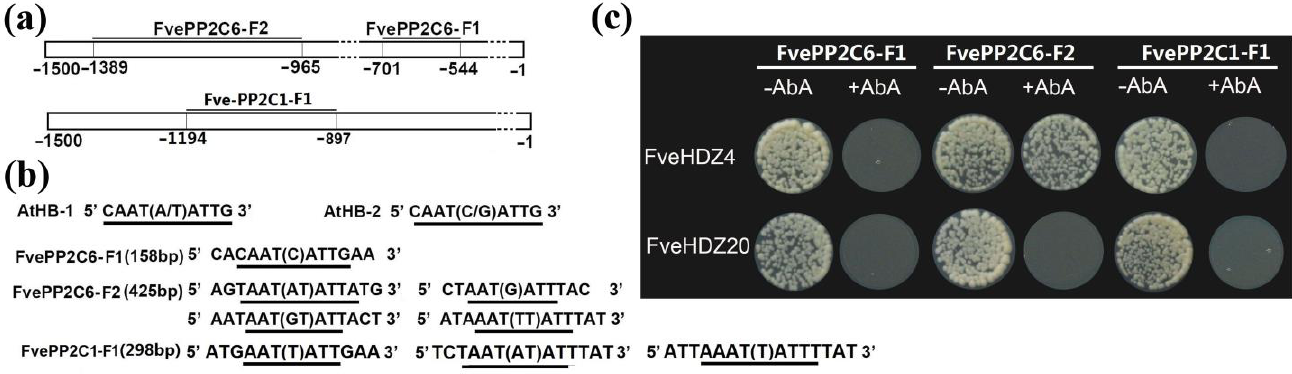
Figure 8. Possible interaction between HD-Zip proteins and FvePP2C promoters tested by yeast one-hybrid (Y1H) analysis. FveHDZ4 and FveHDZ20 proteins, as well as two fragments from the FvePP2C6 promoter (FvePP2C6-F1 and FvePP2C6-F2, the upper in ( a )) and one fragment from the FvePP2C1 promoter (FvePP2C1-F1, the lower in ( a )), were used in the Y1H assay ( c ). ( a ) Location of the selected fragments in the promoters of FvePP2C6 (upper) and FvePP2C1 (lower). The upstream 1500 bp region of the transcription start site (ATG) was shown as the promoter. ( b ) Binding sequences of Arabidopsis HD-Zip proteins ATHB-1 and ATHB-2 [4], and the putative FveHDZ-binding sequences found in FvePP2C6-F1, FvePP2C6-F2, and FvePP2C1-F1 (indicated with the underline). The length of each selected fragment as indicated in the parentheses behind the fragment name. ( c ) Yeast one-hybrid (Y1H) analysis between FveHDZ4/FveHDZ20 proteins and the FvePP2C6 and FvePP2C1 promoter fragments. No basal activity of these promoter fragments was detected on the medium containing Aureobasidin A (AbA, 200 ng/mL). –AbA and +AbA means without and with AbA in the medium,